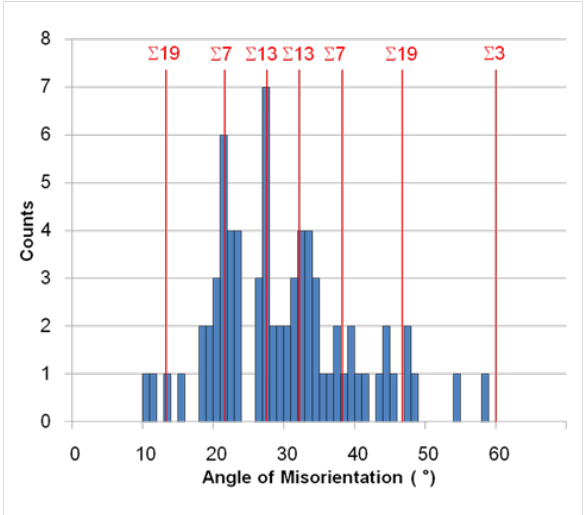
Figure 6: Histogram showing the misorientations around the common <111> direction between adjacent crystals in the Mourning Cloak nanonipple